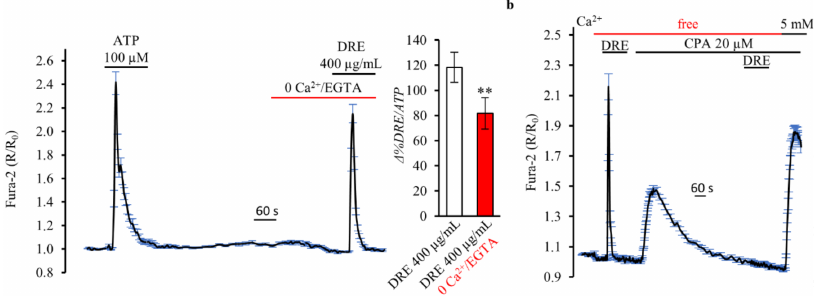
Figure 3. DRE increases intracellular Ca 2+ levels in a Ca 2+ -free extracellular solution as measured by Fura-2 in single HEK293 cells. ( a ) Response of Fura-2-loaded HEK293 cells to the Ca 2+ -mobilizing agonist ATP (100 µ M) compared with the Ca 2+ increase elicited by DRE (400 µ g/mL) in the absence of extracellular Ca 2+ . The reported values are means ± SE from all the responsive cells on a single coverslip. Right inset: Changes in the Fura-2 ratio in response to DRE (400 µ g/mL) in the presence or absence of extracellular Ca 2+ , normalized to the response induced by ATP. The reported values are means ± SE from all the responsive cells of all experiments performed (** p < 0.01 vs. DRE with Ca 2+ ). ( b ) Real-time measurements of intracellular Ca 2+ levels in response to DRE (400 µ g/mL) before and after application of 20 µ M cyclopiazonic acid (CPA) in the absence or presence of extracellular Ca 2+ (5.0 mM) in Fura-2-loaded HEK293. The reported values are means ± SE from all the responsive cells on a single